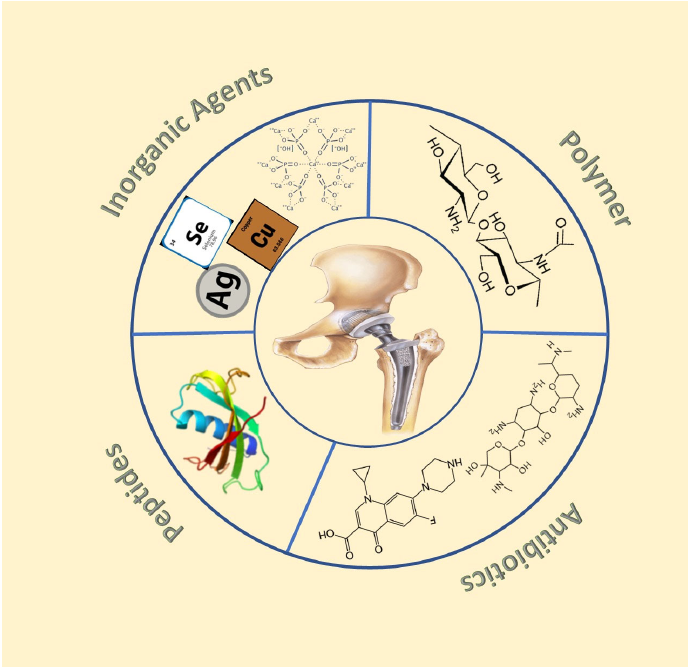
Figure 2. Antibacterial coatings on titanium implants.